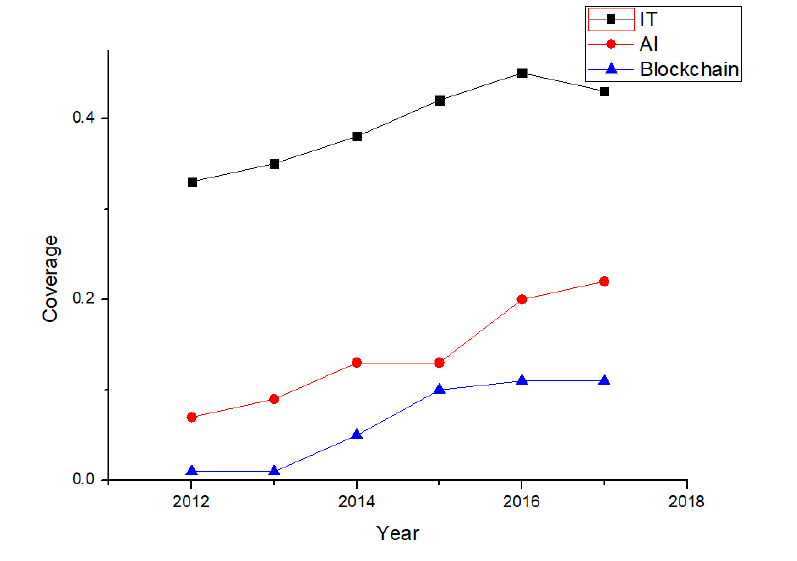
Figure 12. Coverage of new IT concepts in the U.S. market (2012–2017).